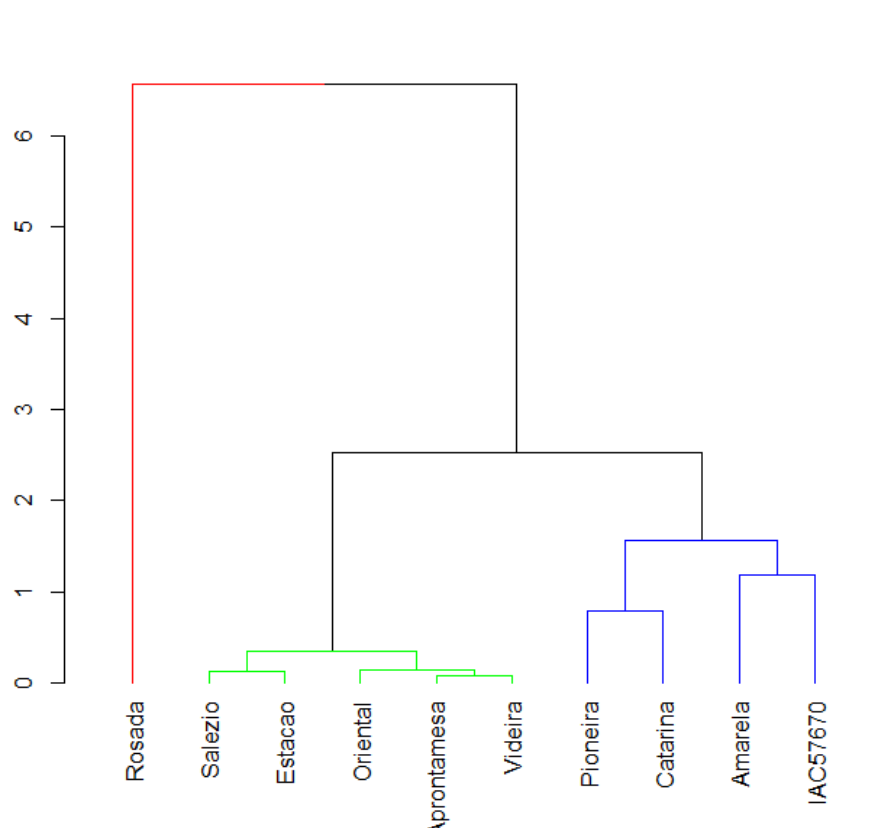
Figure 7: Dendrogram of cassava genotypes in respect to their carotenoid composition determined by RP-HPLC, followed by hierarchical clustering analysis (UPGMA method - 97.61% of cophe- netic correlation). The similarity among genotypes of the same cluster is statistically significant (p ≤ 0.05) when the branches in the dendrogram show the same color. Significance determined by Simprof analysis (Similarity Profile Analysis) from R Clustsig package in accordance with Clarke, Somerfield & Gorley (2008).